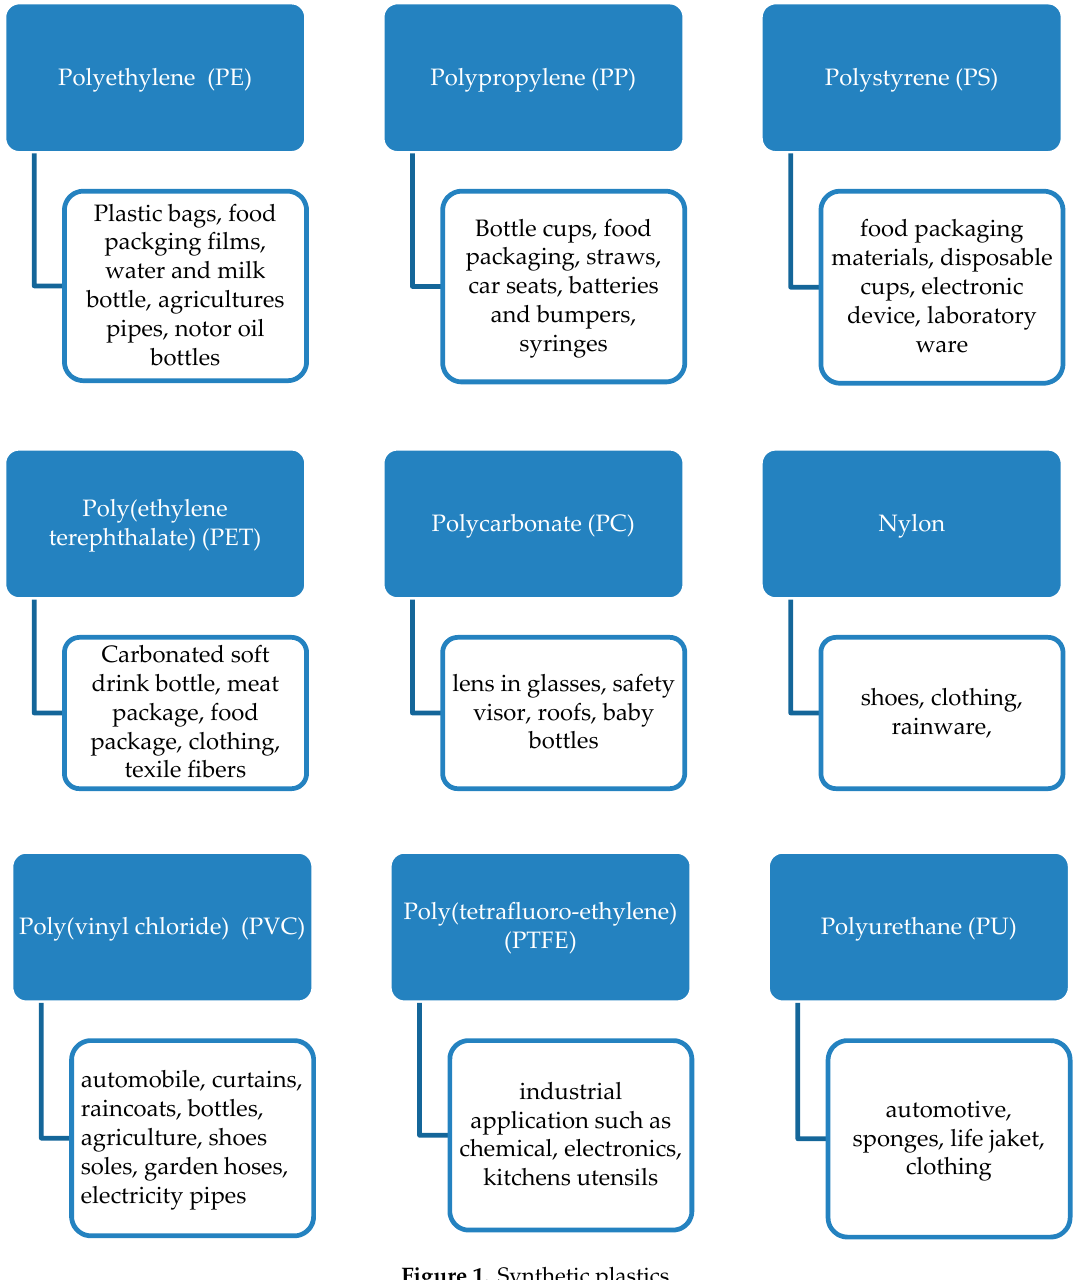
Figure 1. Synthetic plastics.